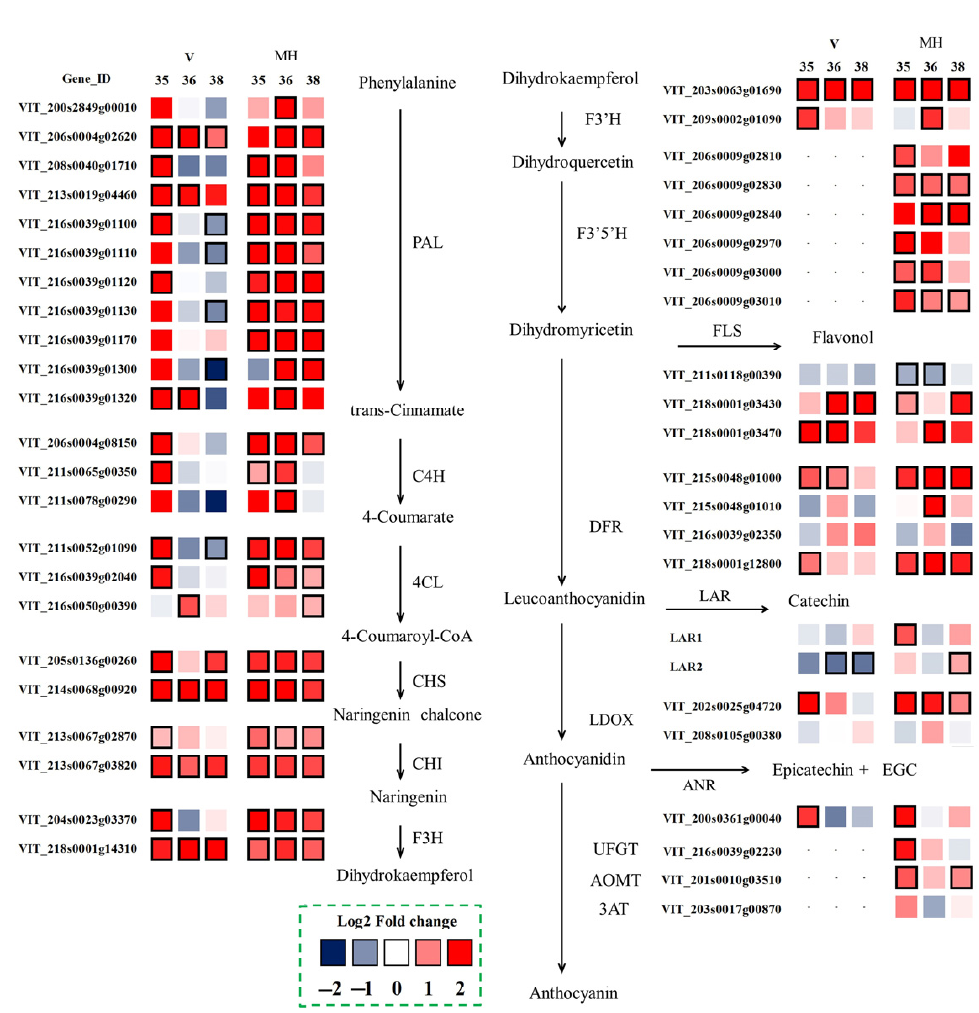
Figure 6. Effect of the growing season on the expression profiles of the flavonoid synthesis pathway during the development of the ‘Muscat Hamburg’ and ‘Victoria’ grapes in 2014. Heatmaps showed the log 2 fold changes between seasons (winter season/summer season). Red block indicated higher gene expression in the winter season berries. Blue block indicated lower gene expression in the winter season berries. Boxes with bold margins indicated differentially expressed genes between the summer and the winter season berries.